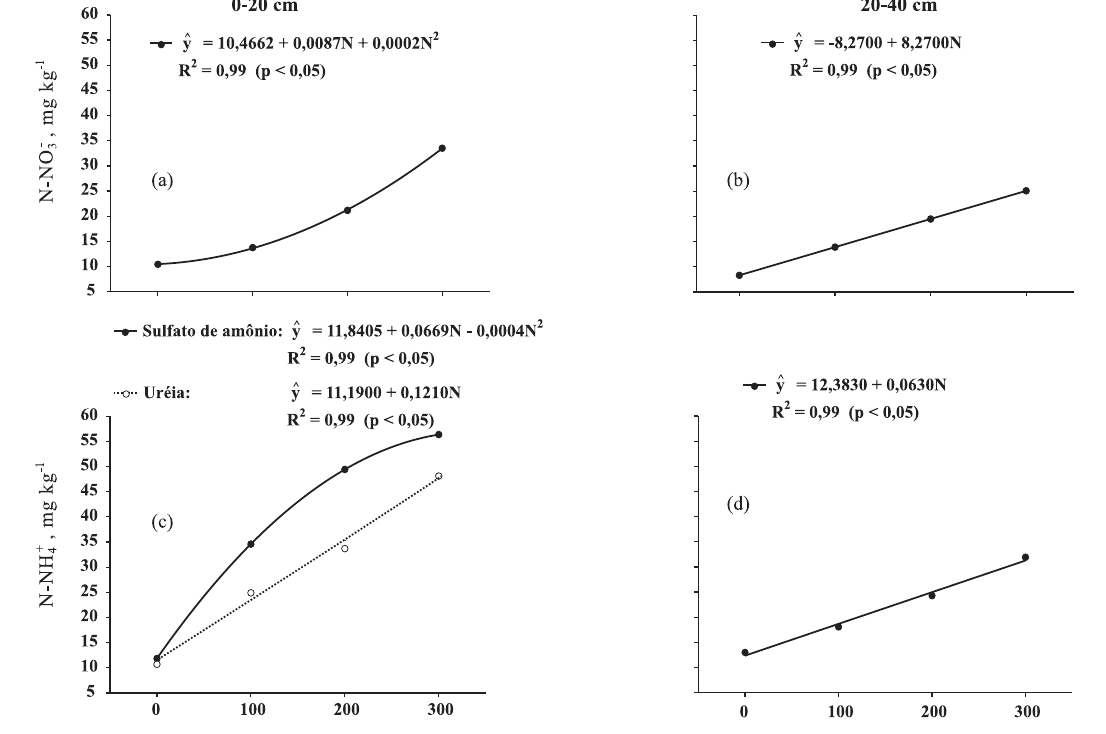
Figura 5. Teores de nitrato (a e b) e de amônio (c e d) do solo nas camadas de 0–20 e 20–40 cm de profundidade em função de doses e, ou, de fontes de